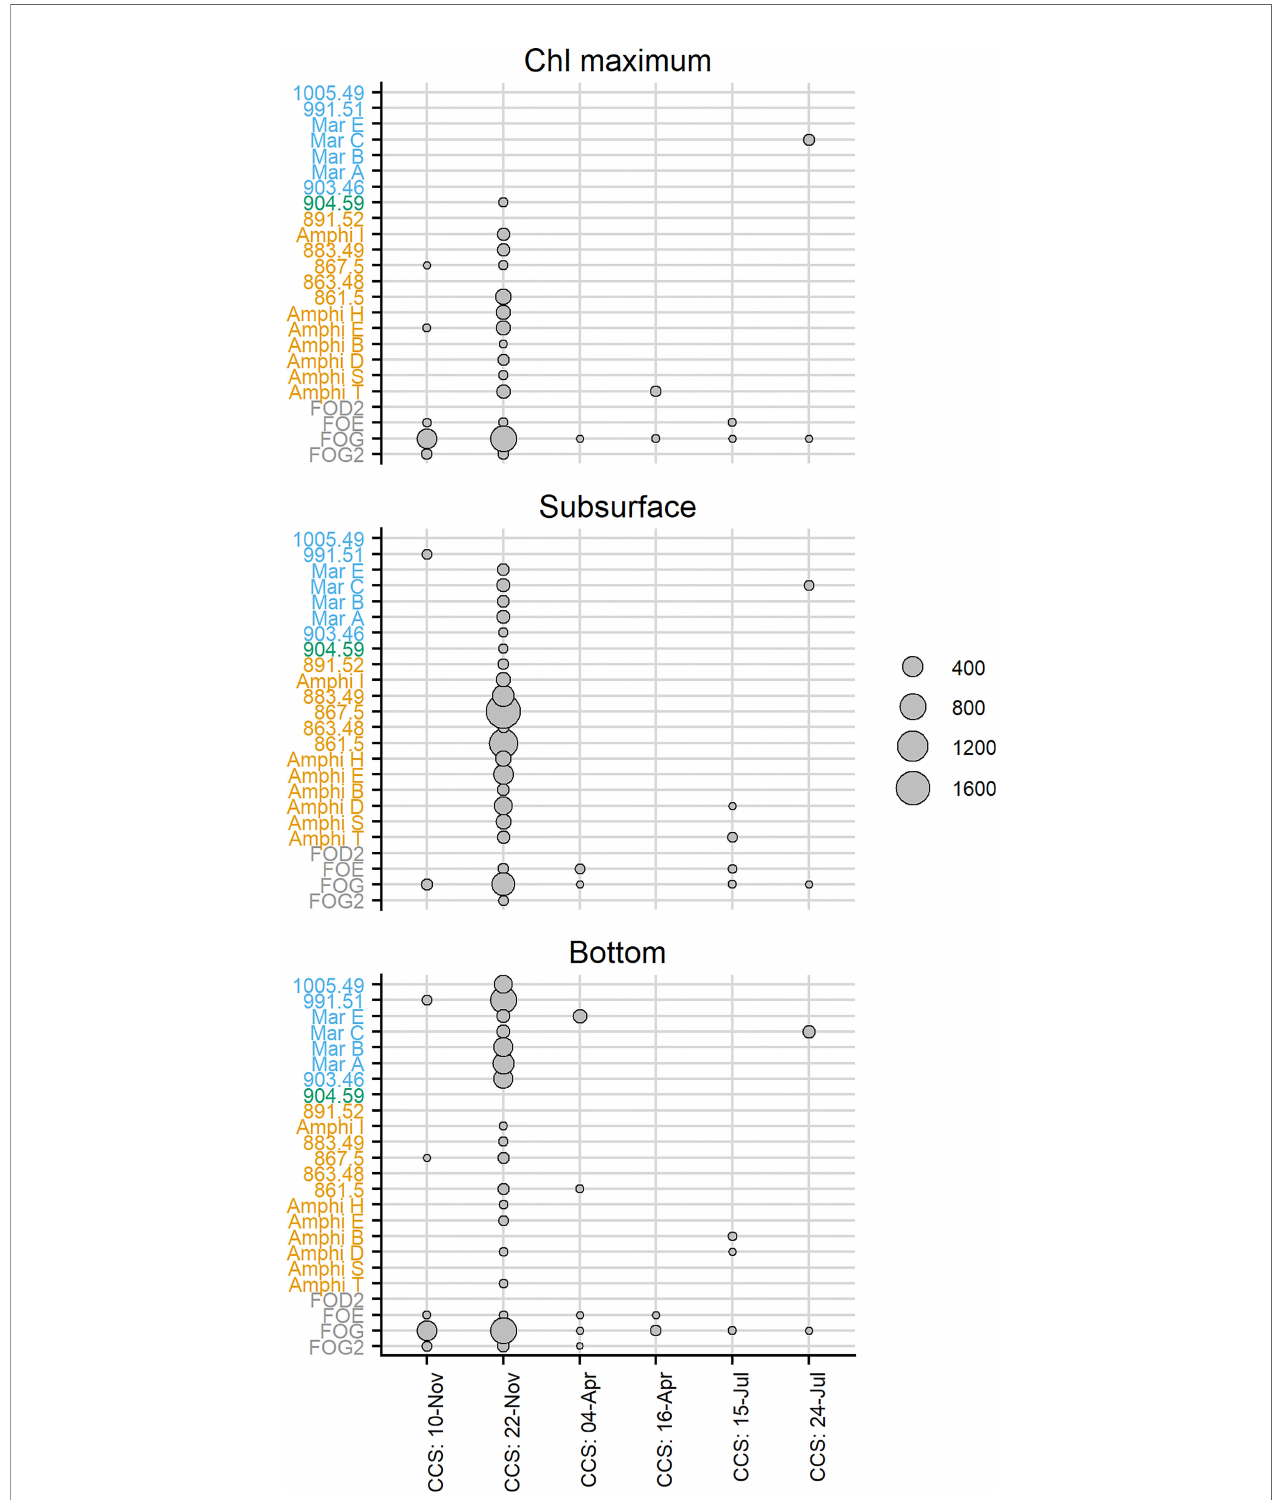
FIGURE 5 | Bubble plot showing normalised ion intensities for each siderophore at the chlorophyll maximum (upper panel), subsurface (middle panel) and at the bottom of the water column (lower panel). Ion intensities were normalised for preconcentration volume and as a function of ESI-MS ionisation ef fi ciency using the response for the [M-2H+Fe] + obtained on detection by ESI-MS, relative to the 56 Fe obtained using ICP-MS. The axis text colour indicates the siderophore families identi fi ed in the samples, with N 6 siderophores indicated in grey text, N 7 in orange text, N 9 in blue text and unknown in green